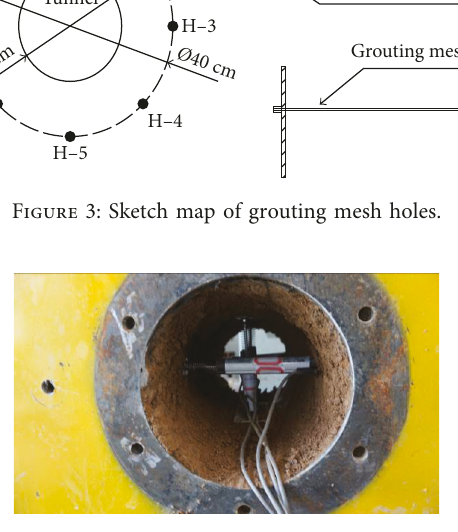
Figure 4: Excavated tunnel and installed displacement